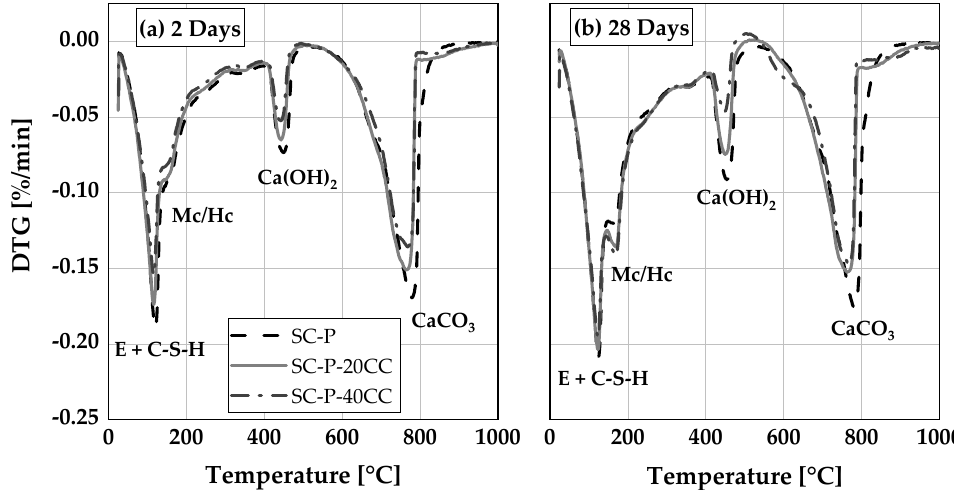
Figure 10. Plastic shrinkage of SC-M specimens.